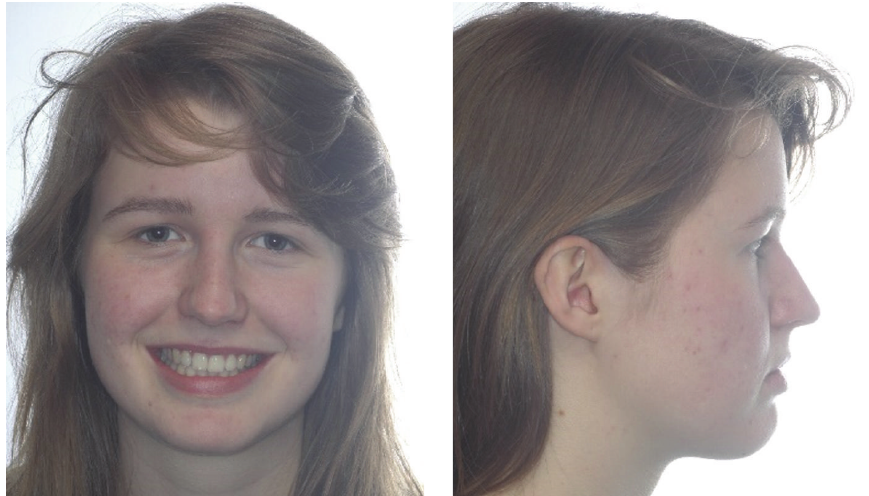
Figure 8: Four-year follow-up extraoral photographs.